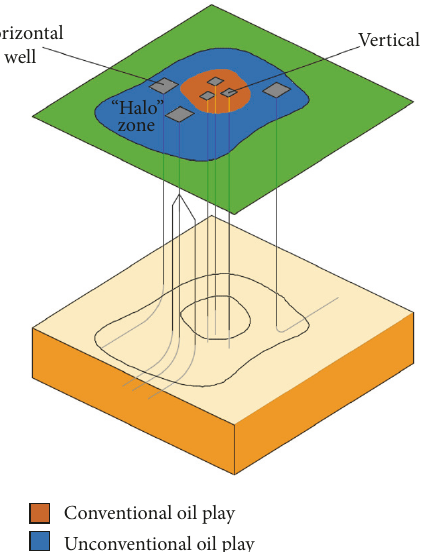
Figure 2: Oil reservoirs are divided into plays, each of which bears particular characteristics. The region in which oil/gas reserves are easilyaccessiblewithconventionaltechnologyiscalledconventional play, whereas those inaccessible regions surrounding conventional play are called unconventional play. They require unconventional technologies to access the oil/gas reserves. At the early stage of production of oil and/or gas from a reservoir, easily accessible oil and gas flow relatively easy to the production wells. When such oil and/orgasaredepleted,oilandgasinthehaloregionareconsidered. Modified from the Canadian Society for Unconventional Resources.